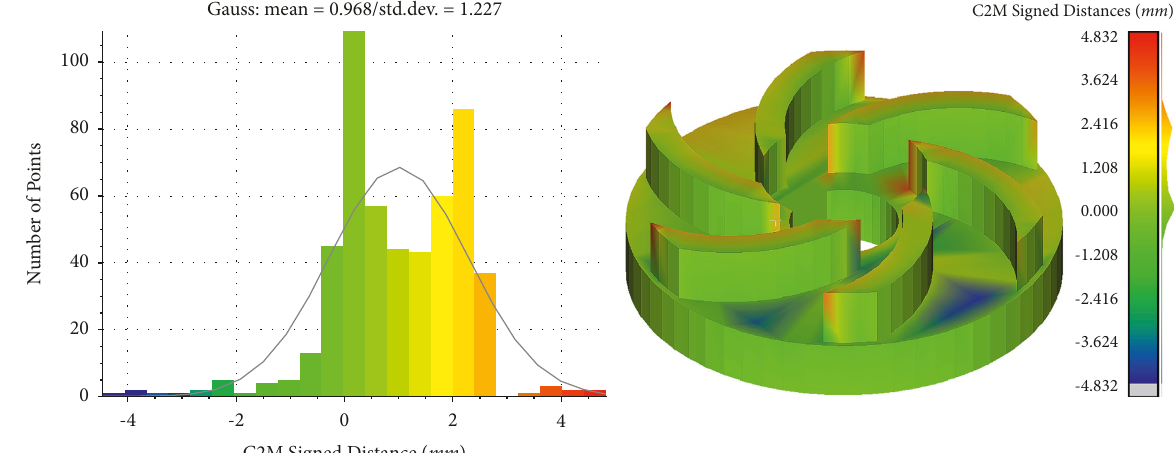
Figure 31: Cloud-to-mesh (C2M) distance of actual CAD model and near-net-shaped CAD